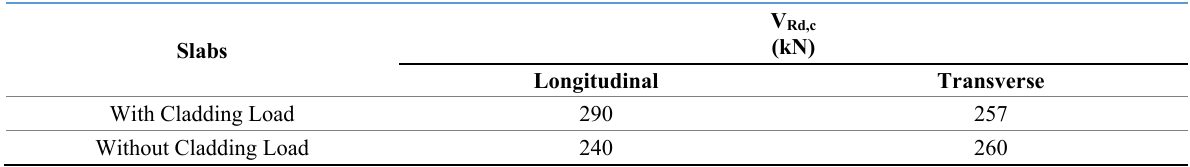
calculated with e k = 0.7 with and without cladding load.